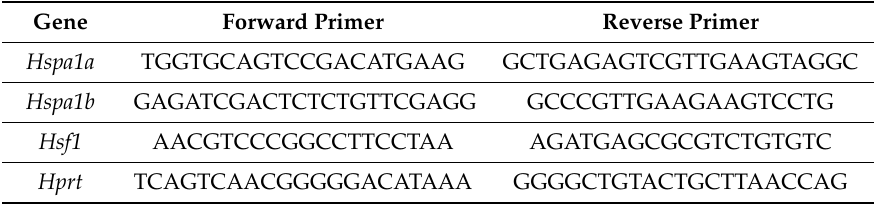
Table 1. Primer Pairs for expression analysis by qPCR of heat shock